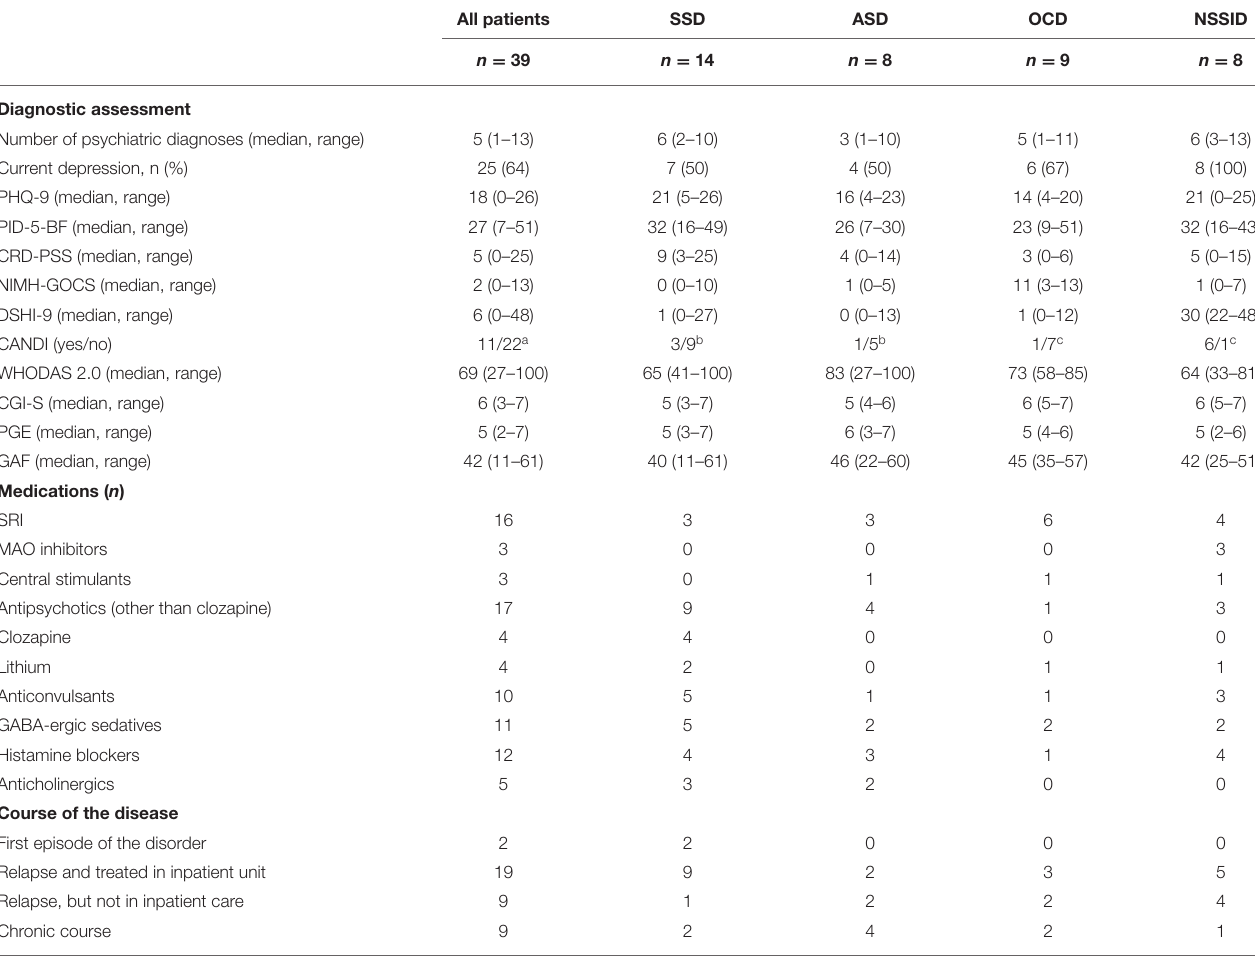
TABLE 2 | Clinical characteristics of